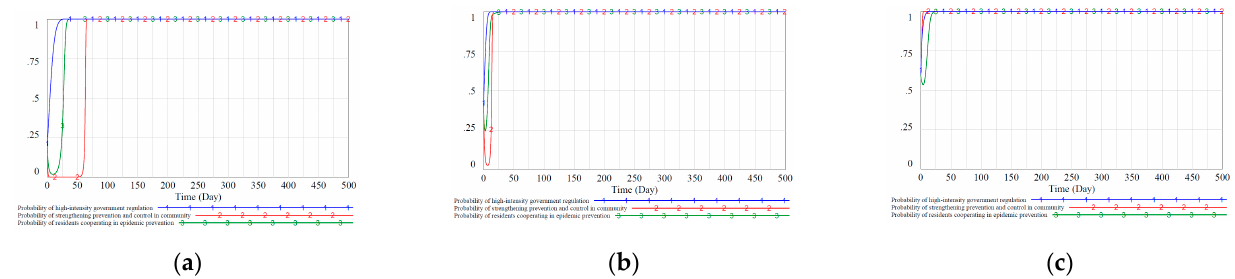
Figure 5. The impact of different initial strategy combinations on the evolutionary stable equilibrium strategy under the dynamic reward and punishment mechanism. ( a ): initial value strategy combinations ( x 0 = 0.2, y 0 = 0.2, z 0 = 0.2 ) . ( b ): initial value strategy combinations ( x 0 = 0.4, y 0 = 0.4, z 0 = 0.4 ) . ( c ): initial value strategy combinations ( x 0 = 0.6, y 0 = 0.6, z 0 = 0.6 )